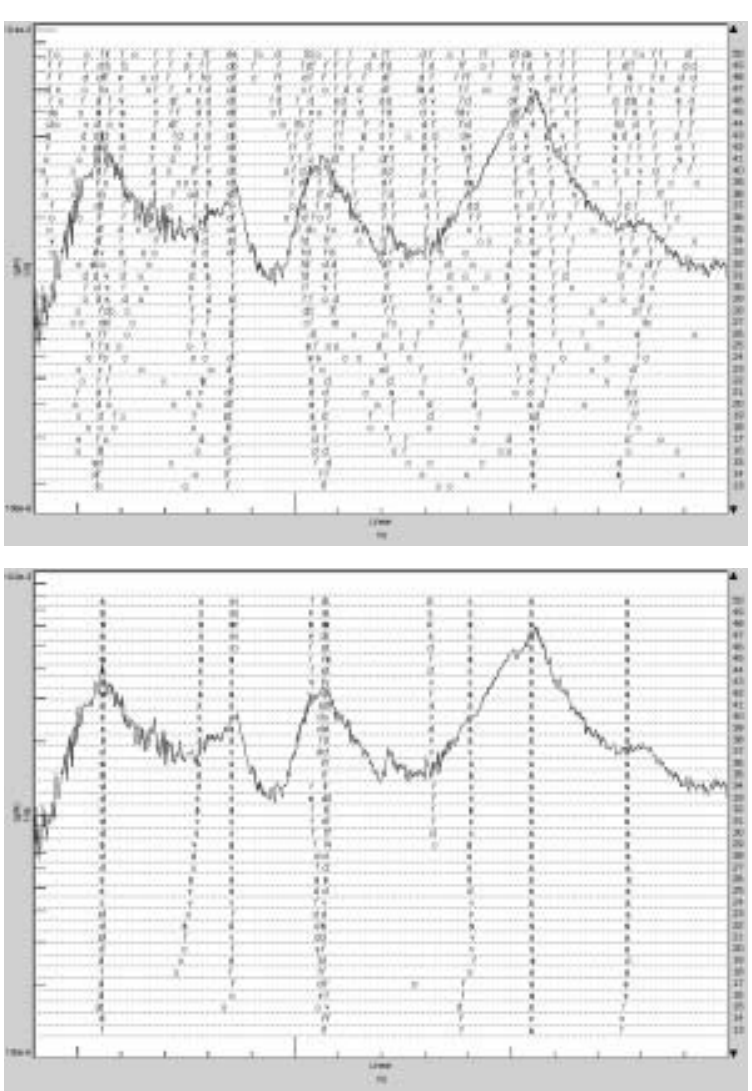
Fig. 6. Stabilisation diagrams obtained by applying different parameter estimation methods to the flight flutter test data: (Top) LSCE; (Bottom) the new PolyMAX